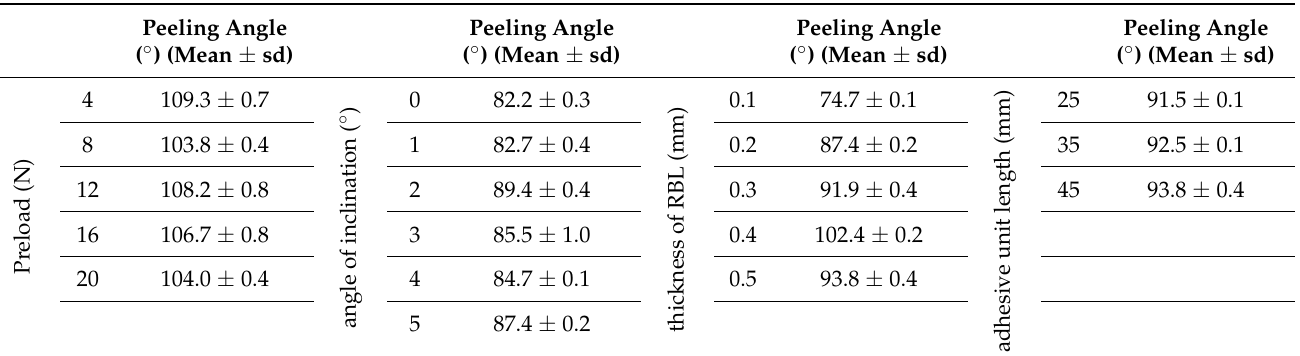
Table 3. Peeling angle θ of adhesive unit for different compression force P , angle of inclination θ 0 , unit length L , and thickness of RBL h b .